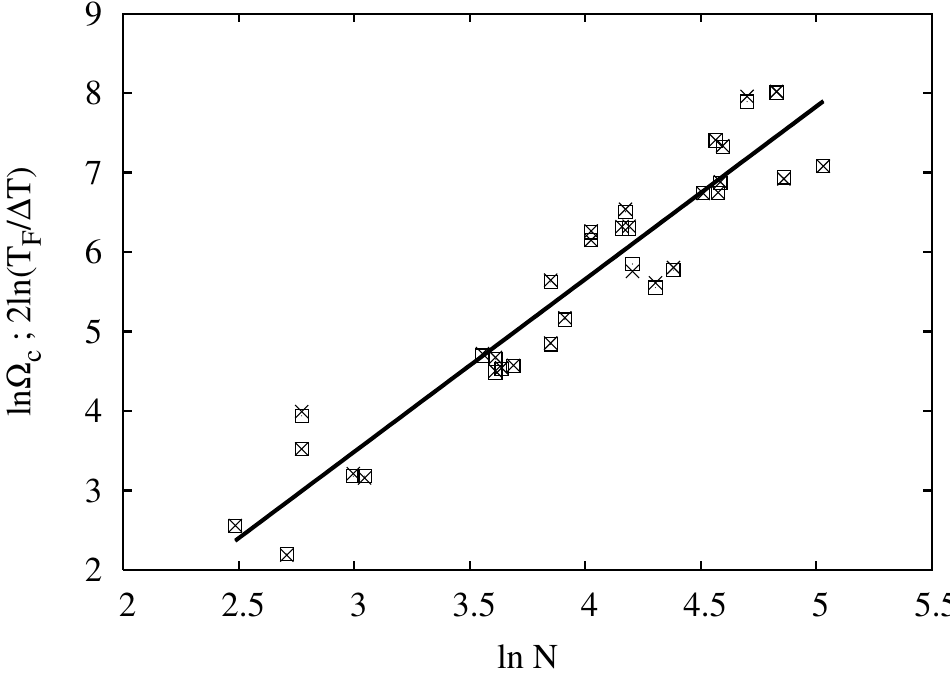
) ( (cid:3) ) vs. ln N . Data taken from the database Figure 1. The dependence of ln Ω c ( × ) and 2ln ( T D ∆ T reported in [17]. ( × ) correspond to the Klimov and Thirumalai Equation (19), while ( (cid:3) ) visualize our result Equation (20). The straight lines, corresponding to the linear fits for both data point collections, are indistinguishable on the